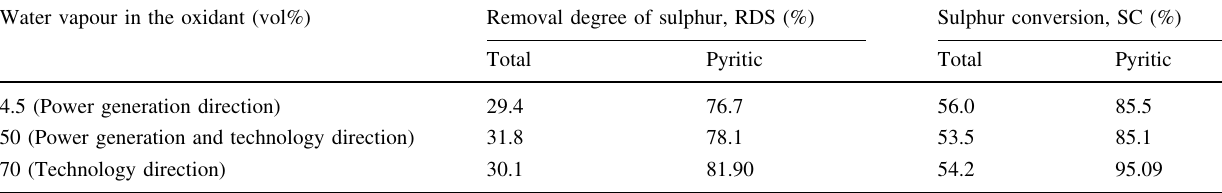
Table 8 Lignite sulphur removal and conversion degrees Water vapour in the oxidant (vol%)